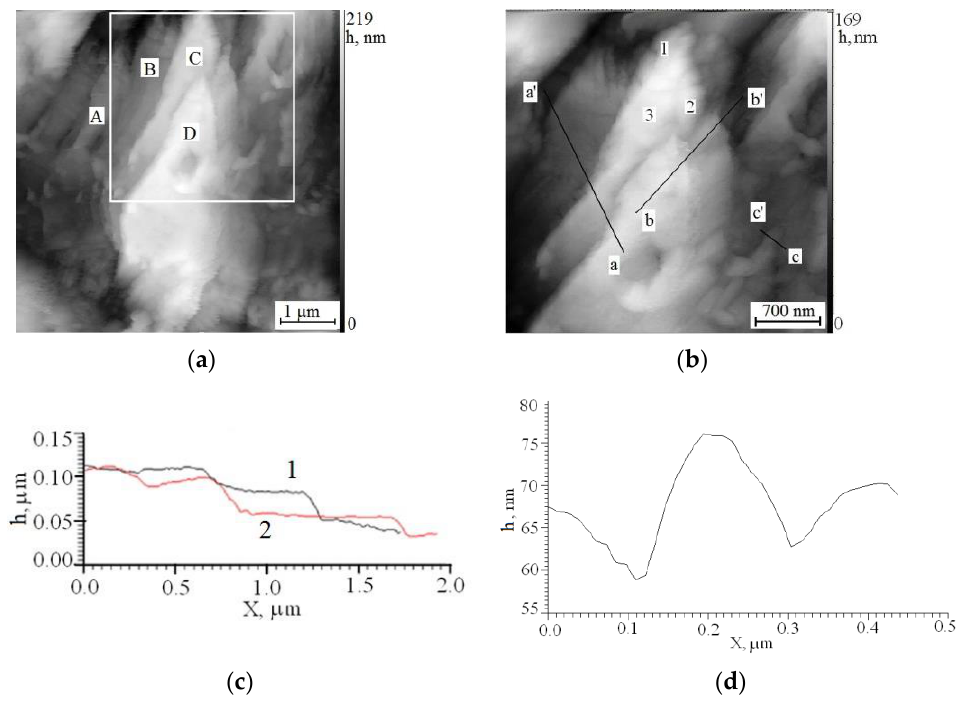
Figure 6. STM image of the structure of the coating deposited with the experimental electrode con- taining 0.25% TiCN: ( a ) packets of plates A, B, C, and D; ( b ) subunits 1, 2, and 3 of plate C; ( c ) cross- sectional profiles along lines a- a’ and b - b’ shown in Figure 6b; and ( d ) cross-sectional profile along line c- c’ shown in Figure 6b.